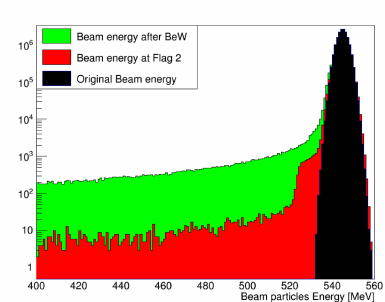
Figure 5 . Beam spot at Flag 2 as seen from the ECal perspective. ∼ 1000 bunch accumulated.